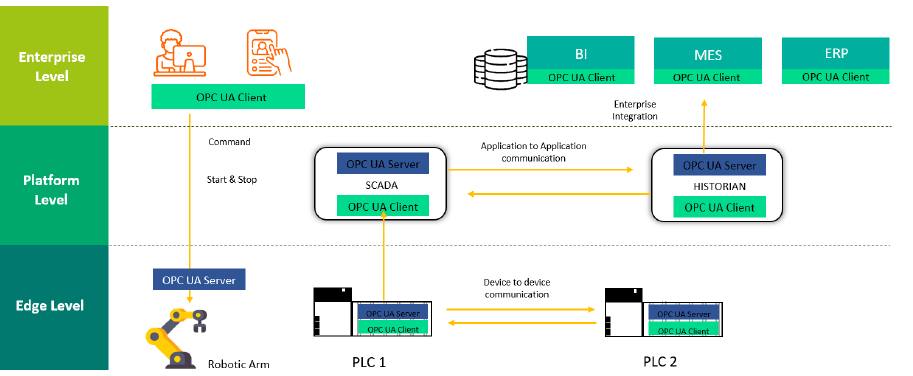
Figure 2. Digital transformation leveraging OPC